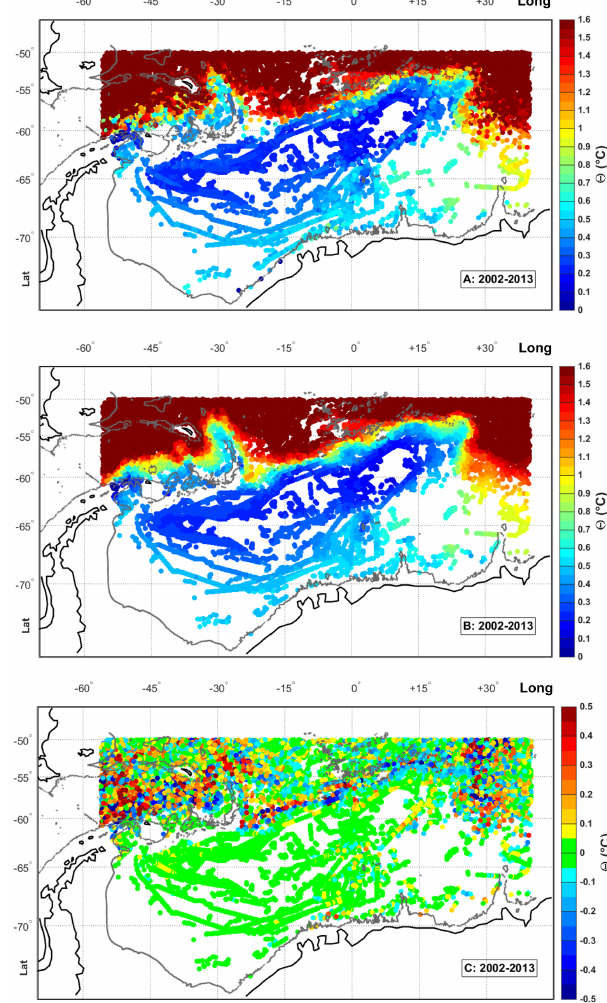
Figure 16. Conservative temperature ( ◦ C) at 800dbar for the entire time period, where panel (a) shows the original float data, panel (b) shows the float data objectively mapped to the profile locations and panel (c) shows the difference where the output in panel (b) is sub- tracted from the original data in panel (a) . The grey contour shows the 2000m